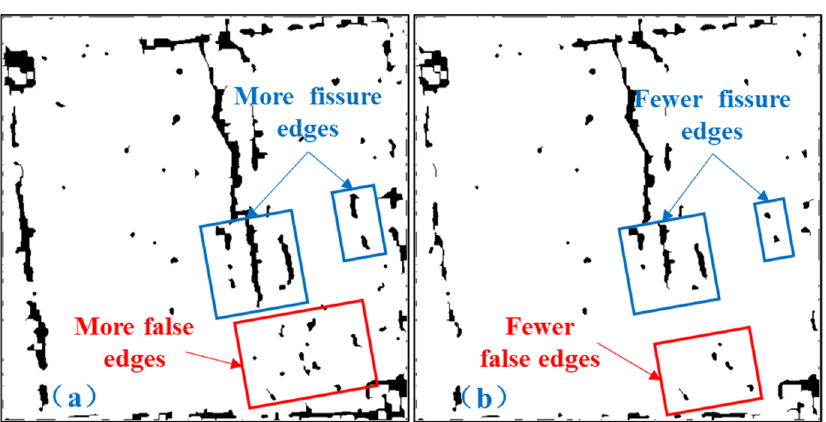
Figure 15. The results of fissure detection using the improved edge detection method at different thresholds. ( a ) The upper limit of Canny is 0.12. ( b ) The upper limit of Canny is 0.15.